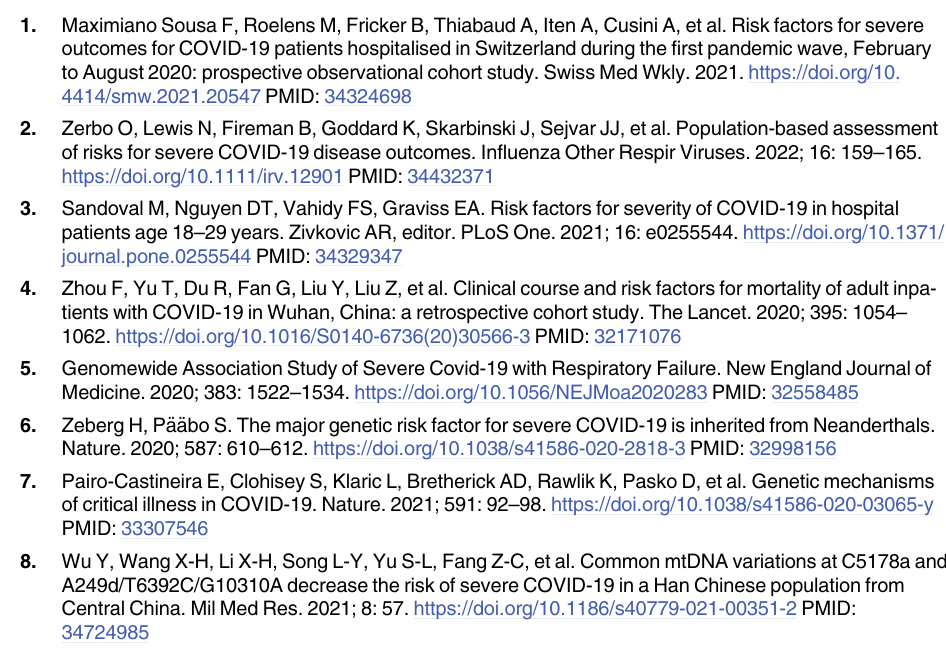
S1 Table. The lists of genes harbouring the significant SNPs for a severe outcome of COVID-19. S2 Table. The lists of genes harbouring the significant SNPs for resistance to